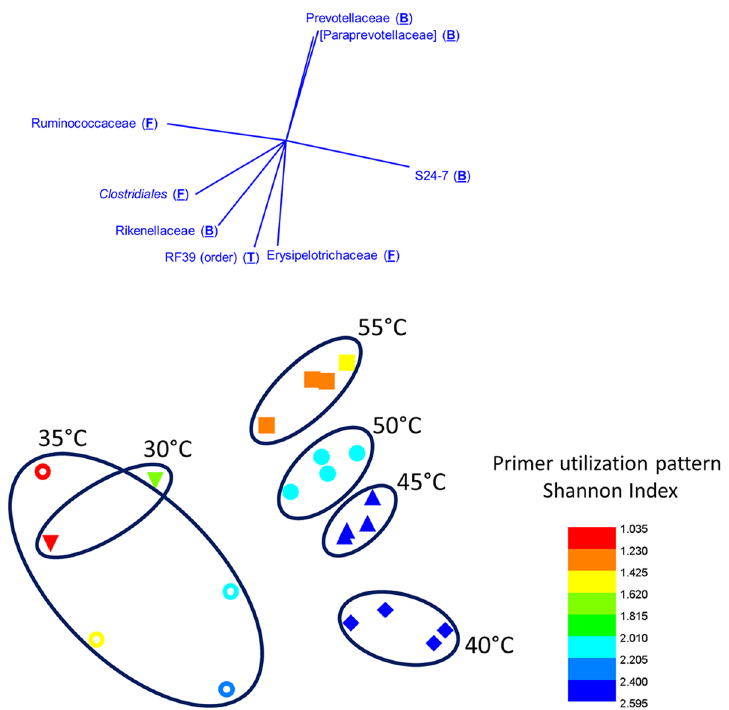
Fig 4. Effect of PEX PCR Stage “ A ” annealing temperature on observed microbial community structure and primer utilization patterns. Non-metric multidimensional scaling (NMDS) plot of fecal microbiome, performed at the taxonomic level of family and based on Bray-Curtis similarity (2D stress = 0.05). Samples were rarefied to 1,250 sequences per sample and no transformation was applied. The analysis is based on a single genomic DNA sample, with PEX PCR stage “ A ” annealing performed at 30°C (down-facing triangles), 35°C (open circles), 40°C (diamonds), 45°C (up-facing triangles), 50°C (closed circles) and 55°C (squares). Symbols are color-coded by the diversity (Shannon Index) of reverse primers ( i . e . 806R) utilized in annealing and elongation during stage “ A ” of PEX PCR. Maximum possible Shannon index for 18 primers in the primer pool is 2.89. Vectors indicate taxa with Pearson correlation of > 0.8 with MDS1 and MDS2